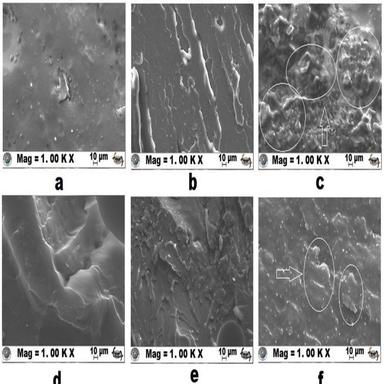
SEM images of: a–c) DGEBA/f-CNT composites; d–f) EPN/f-CNT composites at 1.0, 1.5 and 2.0 wt% of filler.